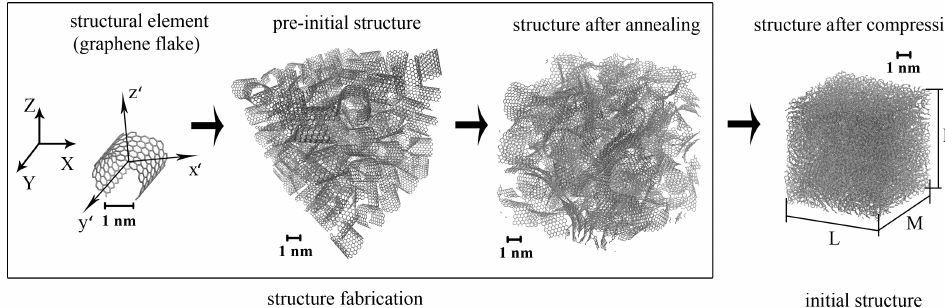
Figure 1. Schematic of the fabrication of Structure A.